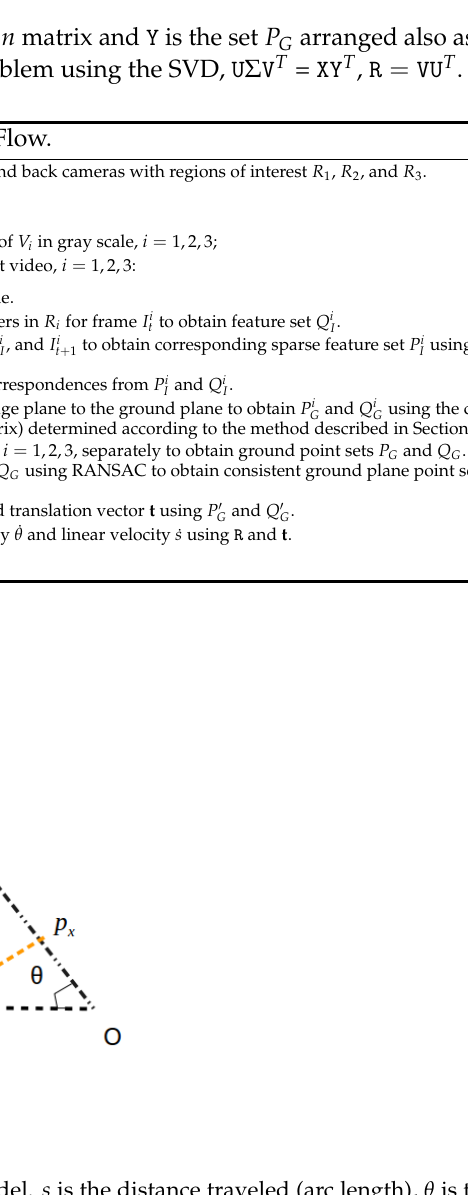
Figure 2. Schematic of vehicle motion model. s is the distance traveled (arc length), θ is the angle turned, [ p x , p y ] T is the representation of a world point [ x , y ] T at time t + 1, and [ q x , q y ] T is the representation of [ x , y ] T at time t . [ t x , t y ] T is the origin of the vehicle coordinate system at time t + 1 represented in the vehicle coordinate system at time t